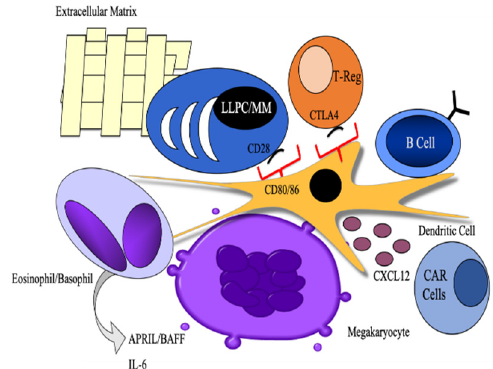
Figure 2. Model the cellular partners and soluble survival signals in the bone marrow microenvironment shared by both (long-lived plasma cells (LLPC) and multiple myeloma (MM). Cellular partners like that of eosinophils, basophils, dendritic xells (pictured in center), CXCL12-abundant reticular (CAR) cells, T regulatory cells, and B cells can provide important cell-cell interactions for the survival of LLPC along with factors held in the extracellular matrix (ECM). Survival signals emanating from these accessory cell subsets include IL-6, APRIL, BAFF, and homing signals like CXCL12. Interactions between CD28 on LLPC / MM and CD80 / CD86 on DC and other myeloid cells can provide survival signals to both LLPC and MM, and promote dendritic cells (DC) production of IL-6 and IDO.